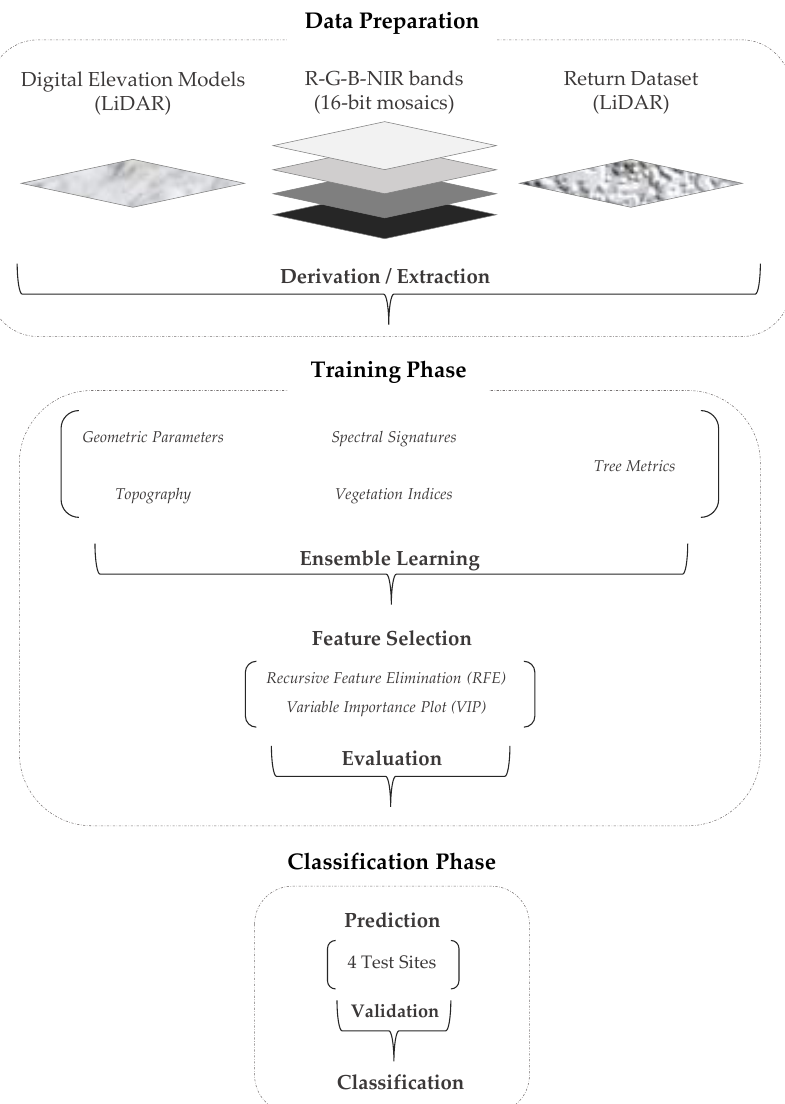
Figure 2. Overview of data processing: First, the raw data were prepared in order to derive a number of categories consisting of attributes and potential variables. Second, during the training phase, the model parameters were tuned and the most significant variables were identified through feature selection methods. Last, the best-fitting model was applied to detect individual conifer species, the broad-leaved classes and snags in the test sites and after a comprehensive validation to the entire study